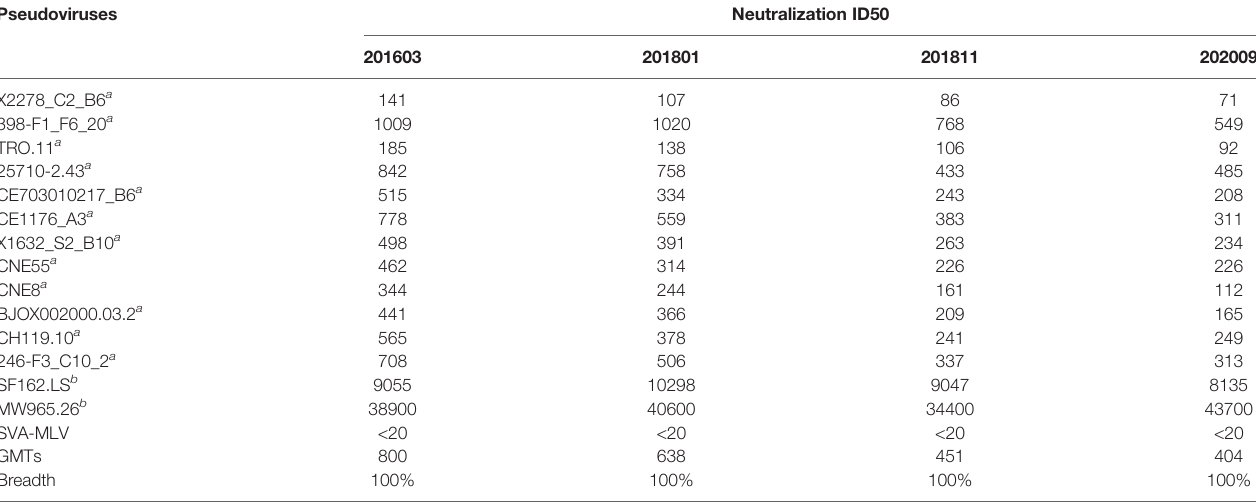
TABLE 2 | Cross-neutralizing activity of the four time-point